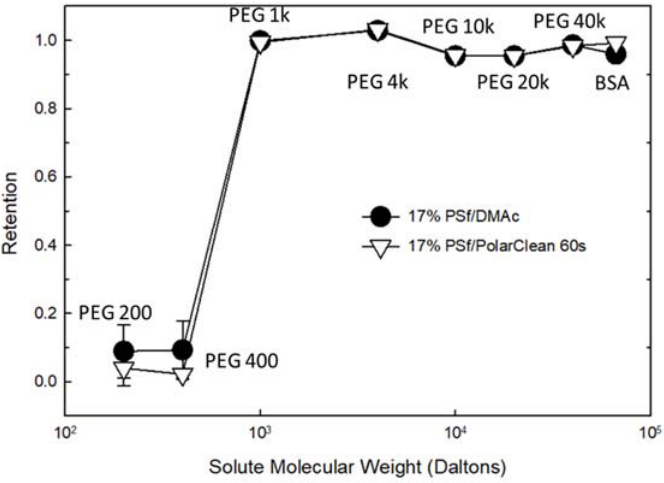
Figure 6. Molecular weight cut-off of PSf membranes.